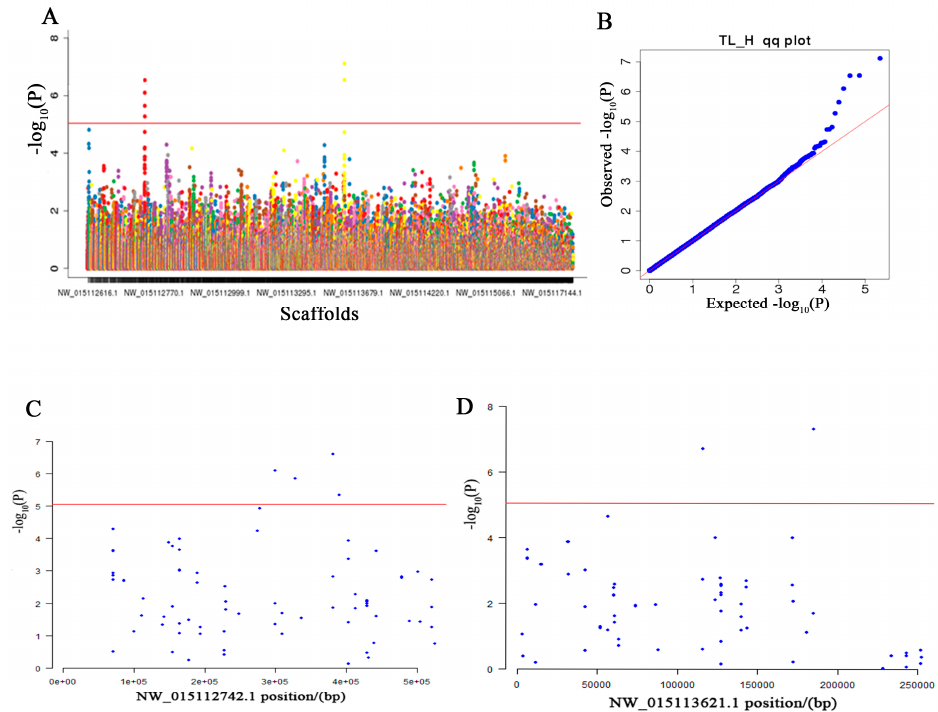
Figure 4. Manhattan plot ( A ) and quantile–quantile (Q–Q) plot ( B ) for the association of all single nucleotide polymorphisms (SNPs) with the ratio of tail fin length to height (TL / H). Regional plots ( C , D ) of the genome-wide significant SNPs. Six SNPs reached genome-wide significant level. In plots A, C and D the red line shows the p -value threshold of 8.79 × 10 − 6 ( − log 10 ( p -value) > 5.06).